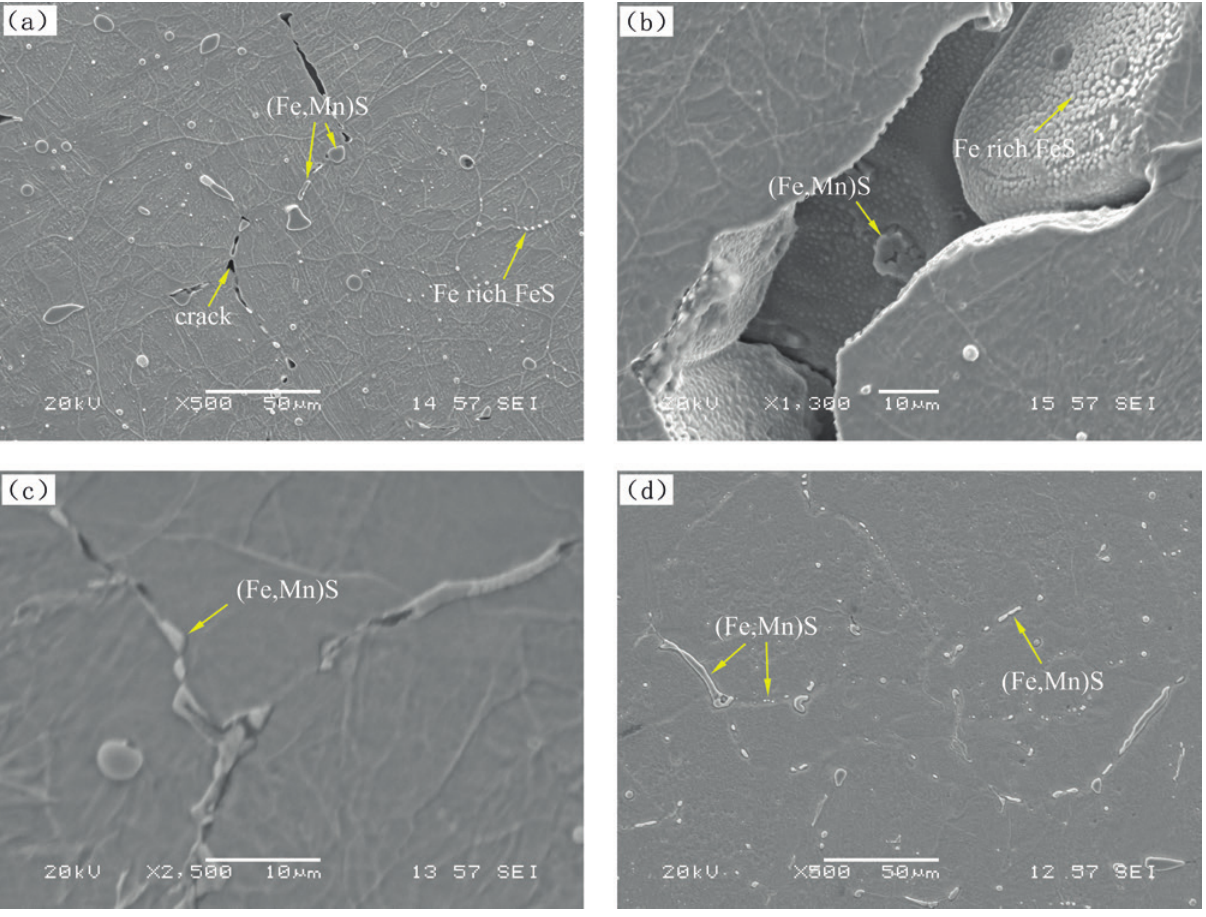
Fig. 5: Typical longitudinal microstructures of quenched fractures for steel 1: (a) microstructure near fracture at 1200 °C; (b) cracks magnification at 1200 °C; (c) microstructure near fracture at 1150 °C; (d) microstructure near fracture at 1100 °C